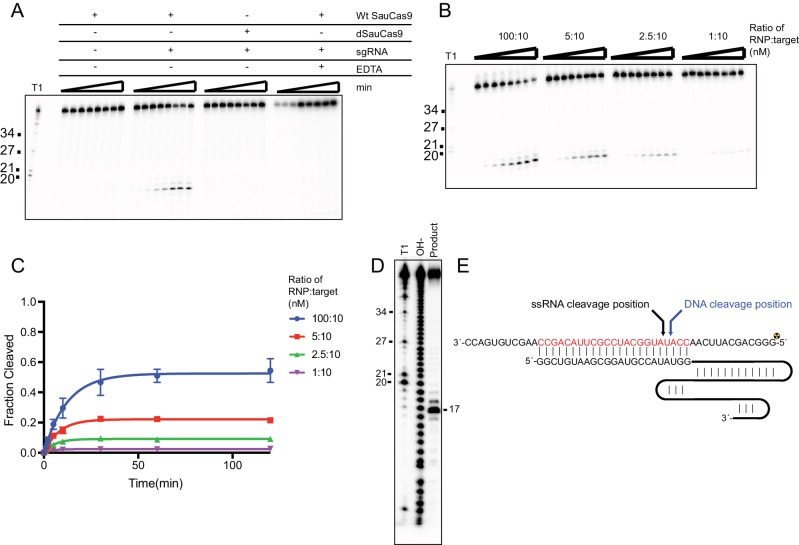
ssRNA cleavage is similar to canonical dsDNA cleavage by Cas9.(A) In vitro SauCas9 cleavage assay of ssRNA. Reactions were incubated with wild-type (Wt SauCas9) or catalytically-inactive dSauCas9 (D10A and N580A) in the presence or absence of sgRNA as indicated above the reactions. EDTA was included at 25 mM where applicable. (B) SauCas9 ssRNA cleavage is single-turnover. SauCas9 RNP was incubated with the RNA target in the various ratios indicated. (A and B) Time points are 0, 1, 2, 5, 10, 30, 60, and 120 min. T1 RNase digest size fragments are given on the left. Target used for cleavage was the pUC ssRNA. (C) Graphical representation of ssRNA fraction cleaved of reactions in (B). Fit was determined in Prism using a single-exponential decay model. Error bars represent the mean ± S.D. (n = 3). (D) Mapping of SauCas9 ssRNA cleavage site. Reaction products from a 2 hr incubation of SauCas9 RNP with the pUC ssRNA target were separated on a 15% denaturing PAGE gel with a hydrolysis and T1 digest ladder to determine exact site of the major cleavage product. (E) Diagram of canonical DNA cleavage position and ssRNA cleavage position as determined in (D).10.7554/eLife.32724.007Figure 1—figure supplement 2—source data 1.Quantification of multi-turnover cleavage.